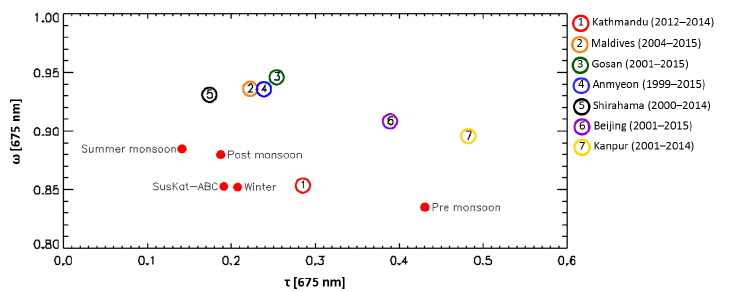
Figure 10. Relationship between the aerosol optical depth and single scattering albedo measured at several sites in East and South Asia (open circle with number, data period in parentheses) and in the Kathmandu Valley, segregated by season (closed circle).